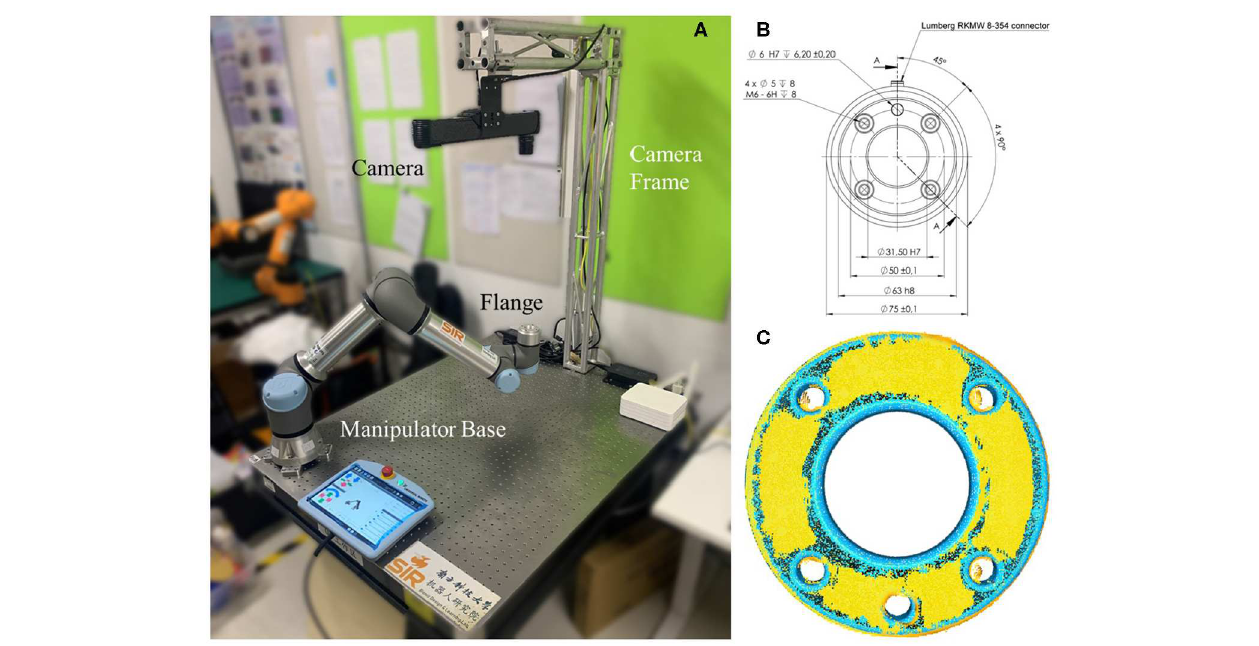
FIGURE 1 | The proposed flange-based hand-eye calibration method, including (A) the experiment setup of a minimum robot system the involves a UR5 e-series and a Photoneo MotionCam-3D camera, both installed on a vibration isolation table; (B) the mechanical drawing of UR5 e-series robot flange that follows ISO 9409-1-50-4-M6; and (C) an illustration of the hand-eye calibration results using the proposed method with accuracy as high as the camera’s, probing the hardware